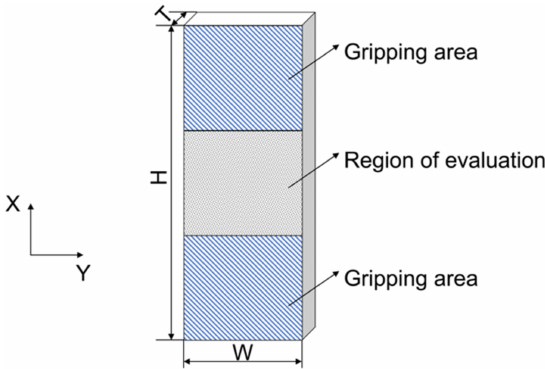
Figure 1. A schematic of the off-axis